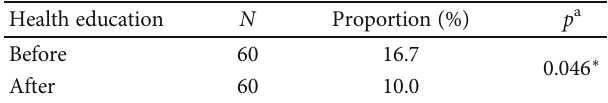
Table 2: Health education and helminthiasis.